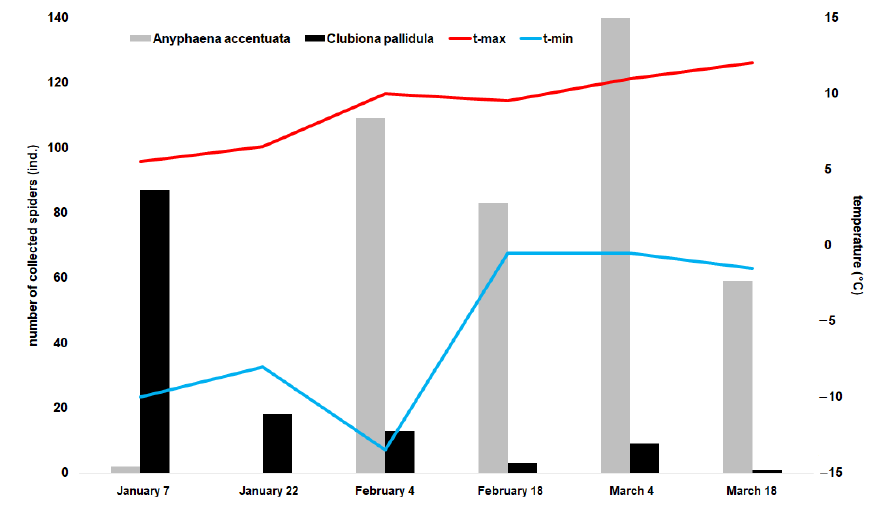
Figure 3. Abundance of Anyphaena accentuata and Clubiona pallidula per box during winter and the maximum and minimum temperature outside the boxes measured 14 days prior to spider collection in 2016.